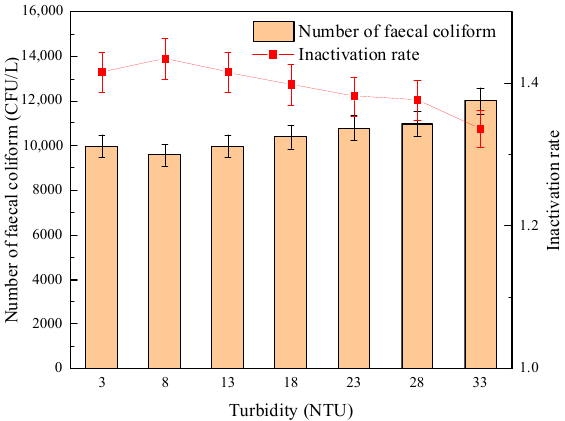
Figure 12. The effect of turbidity on the sterilization effect of “Method A”.